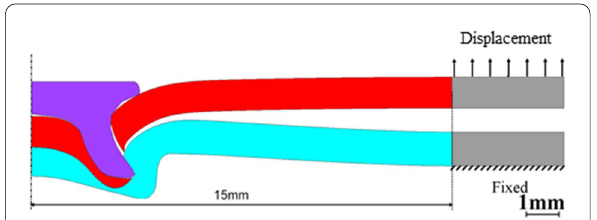
Figure 6 2D FE model of cross-tension test for SPR